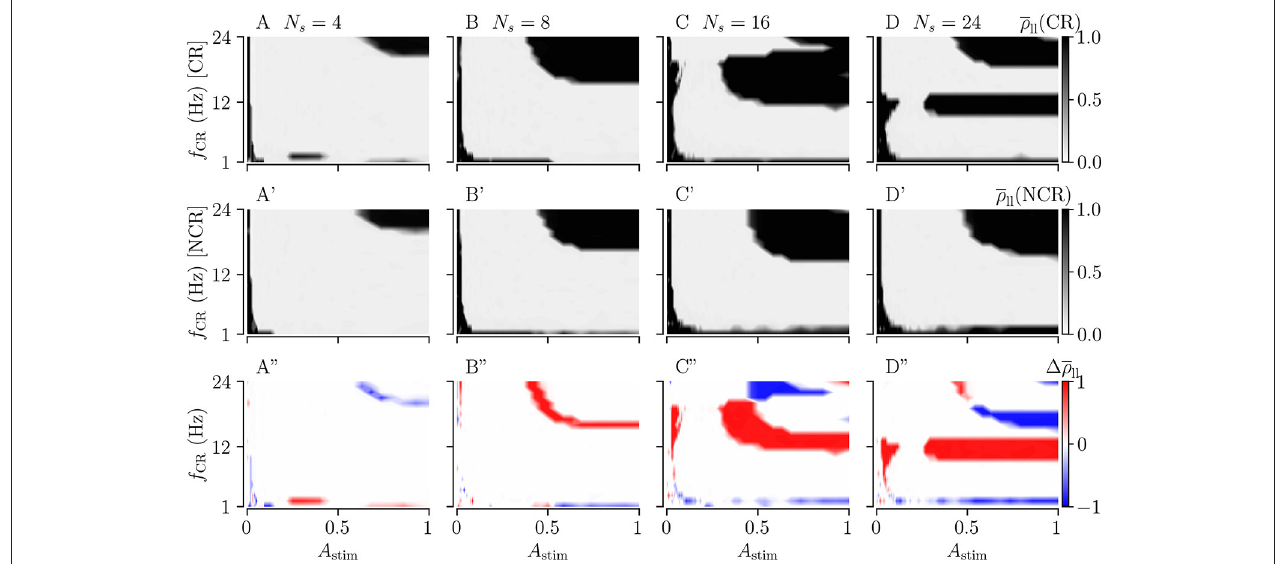
FIGURE 9 | Long-lasting effects of CR and NCR stimulations as a function of CR frequency, f CR , and simulation strength, A stim . (A–D) The long-lasting Kuramoto order parameter for CR stimulation as a function of stimulation frequency and stimulation strength for N s = 4,8,16,and 24. (A’–D’) Same as the top row but for NCR with σ CR = 1. (A”–D”) The difference between the long-lasting Kuramoto order parameter for CR and NCR, 1ρ ll = rho ll (CR) − rho ll (NCR). In the red colored parameter regions, the Kuramoto order parameter for CR was larger than that for NCR, in the blue colored regions CR led to long-lasting desynchronization whereas NCR did not. The columns correspond to different numbers of stimulation sites, N s = 4,8,16,and 24,